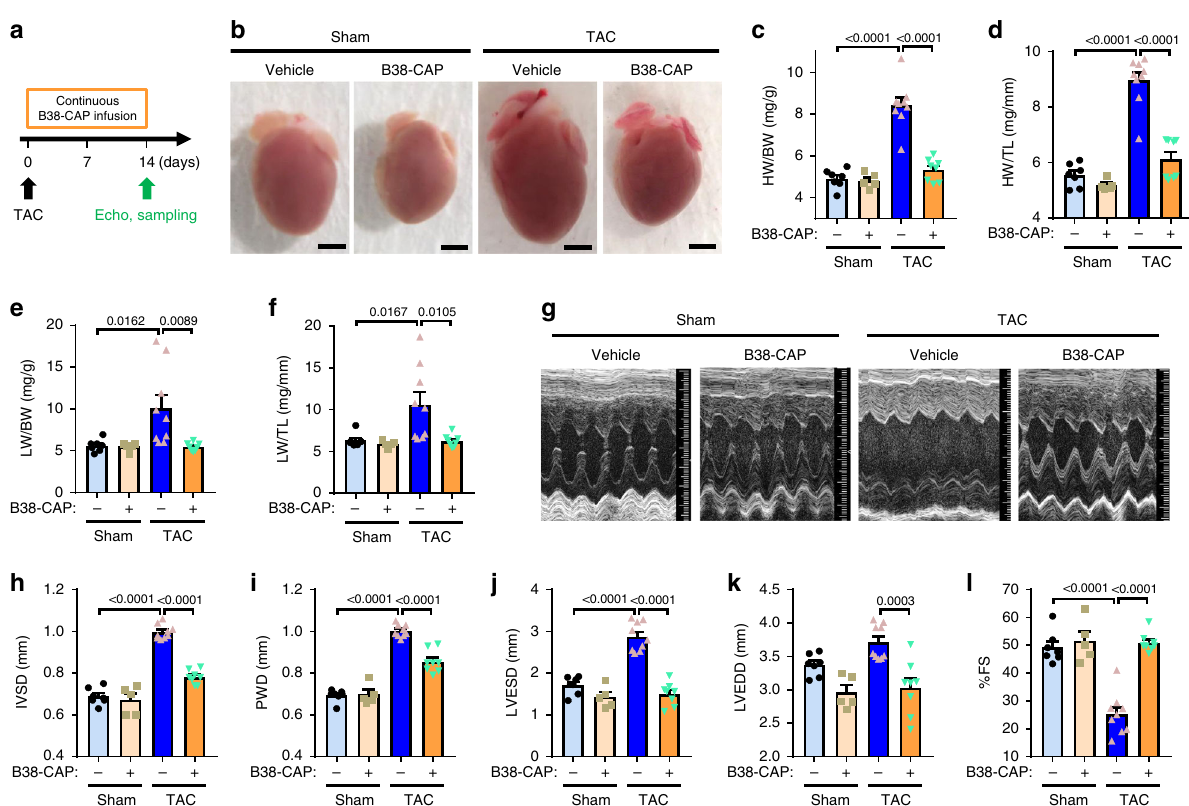
Fig. 4 B38-CAP mitigates pressure overload (TAC)-induced cardiac dysfunction and hypertrophy. a Experimental protocol. The mice were subjected to the surgery of transverse aortic constriction (TAC) surgery and then continuous infusion of B38-CAP (2 mg kg − 1 per day) was initiated. b – f B38-CAP suppressed cardiac hypertrophy. Representative photograph ( b ) of the hearts of mice under TAC. Bars indicate 2 mm. HW/BW ( c ), HW/TL ( d ), lung weight to body weight ratio (LW/BW) ( e ), and lung weight to tibia length ratio (LW/TL) ( f ) in the mice treated with sham + vehicle ( n = 7), sham + B38- CAP ( n = 5), TAC + vehicle ( n = 9), and TAC + B38-CAP ( n = 8). g – l Echocardiography measurements. Representative M-mode echocardiography images ( g ), measurements of IVSD ( h ), PWD ( i ), LVESD ( j ), LVEDD ( k ), and %FS ( l ) are shown. Complete echocardiography data are shown in Supplementary Table 4. All values are means ± SEM. c – f , h – l One-way ANOVA with Sidak ’ s multiple-comparisons test. Numbers above square brackets show signi fi cant P